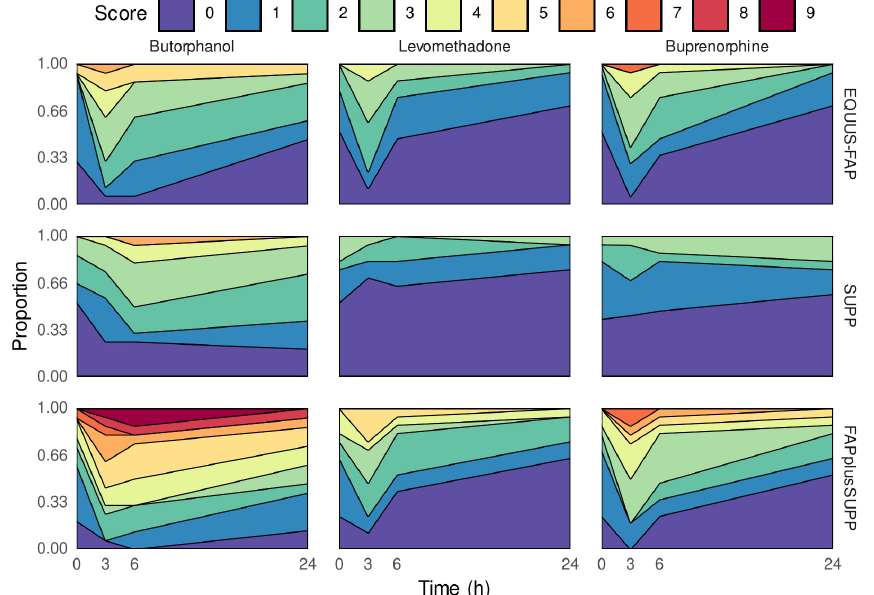
Figure 3. Evaluation of pain development over time using (from top to bottom) EQUUS-FAP, SUPP and the FAPplusSUPP. Total pain score at the respective time of measurement (0–24 h) postoperatively on the X -axis and the proportion of horses on the Y -axis with the total score awarded.